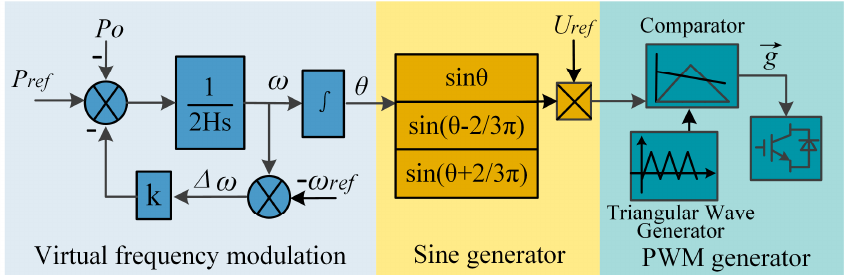
Figure 1. The control scheme of VSG-IIDG.